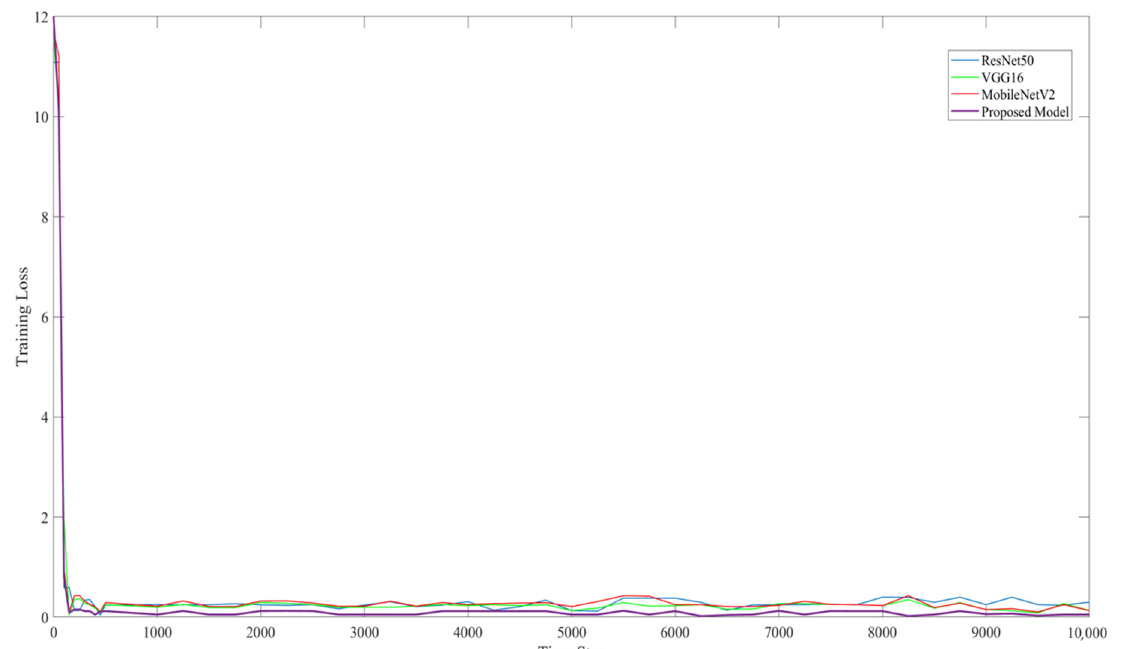
Figure 16. Training loss of ResNet50, VG16, MobileNetV2, and the proposed model on image clas- sification.